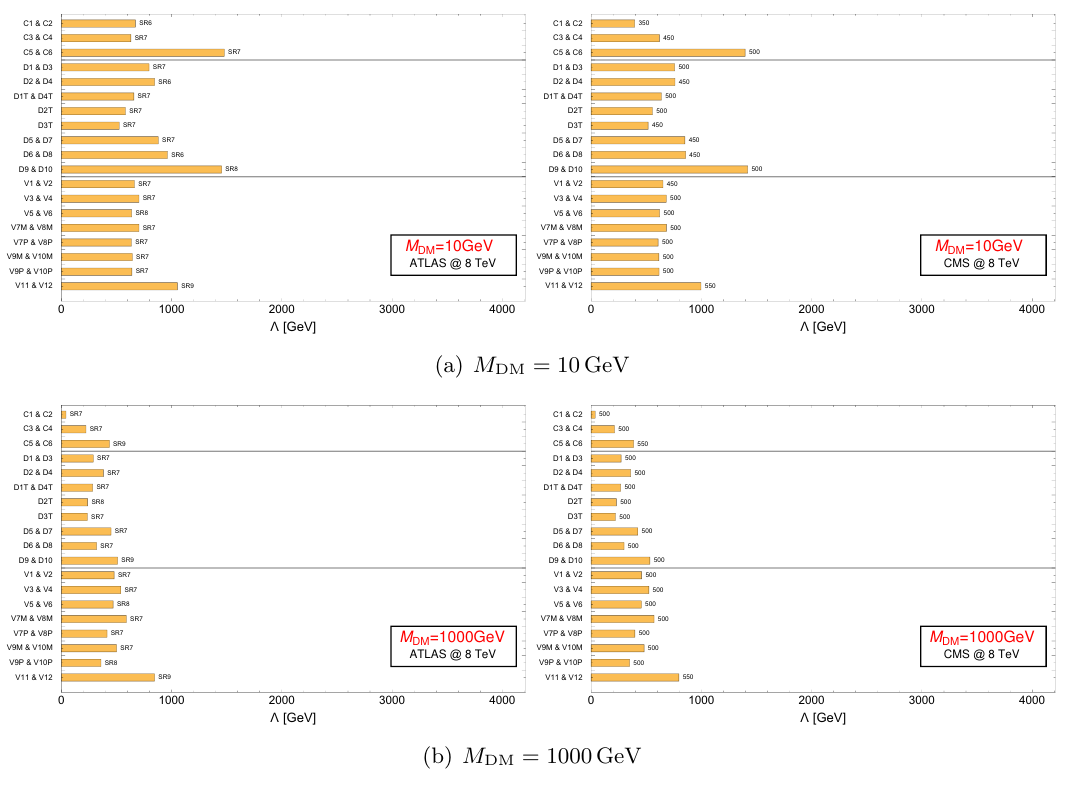
Figure 13 . Observed 95% CL limits on the UV cut-o(cid:11) (cid:3) from LHC 8 TeV data: from the ATLAS search(left) of ref. [1] and from the CMS search (right) of ref. [2]. See the caption of (cid:12)gure 9 for more details about the interpretation of the